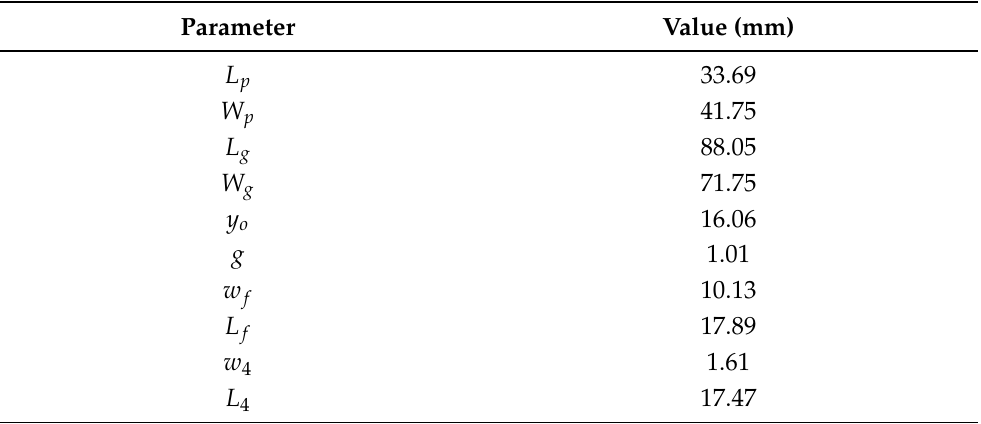
Table 1. The final design parameters of the fabricated